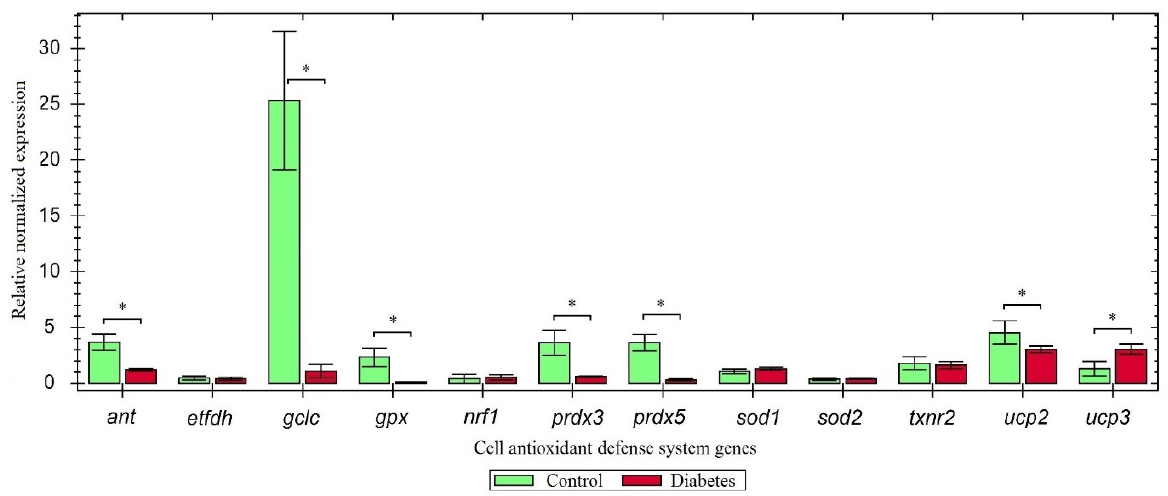
Figure 2. Expression pattern of genes-components of the cell antioxidant defense system in diabetes (* p ≤ 0.05). The decrease in the gene expression could be related to a high content of oxidized proteins, lipids, and DNA in diabetic animals, which might reduce the ability of the cells to neutralize free radicals. In particular, the largest difference in the mRNA expression levels was observed for the gclc gene, which is presumably the reason for the decrease in the amount of glutathione in the cell. The downregulation of the gpx , prdx3 , and prdx5 genes encoding antioxidant proteins induces cellular susceptibility to oxidative stress, while the protein encoded by the ant gene plays an important role in the generation of ROS. SkQ1 exhibited no toxic effects in the organism. In some cases, it enhanced the cell’s enzymatic defense system against ROS; in other cases, it took on a significant portion of the protective functions (Figure 3). Figure 3. Effect of antioxidant SkQ1 on gene expression (* p ≤ 0.05). SkQ1 injection increased the expression of the gclc gene and the gene for its tran- scription factor ( nrf1 ). Apparently, SkQ1 takes on the main antioxidant function, which